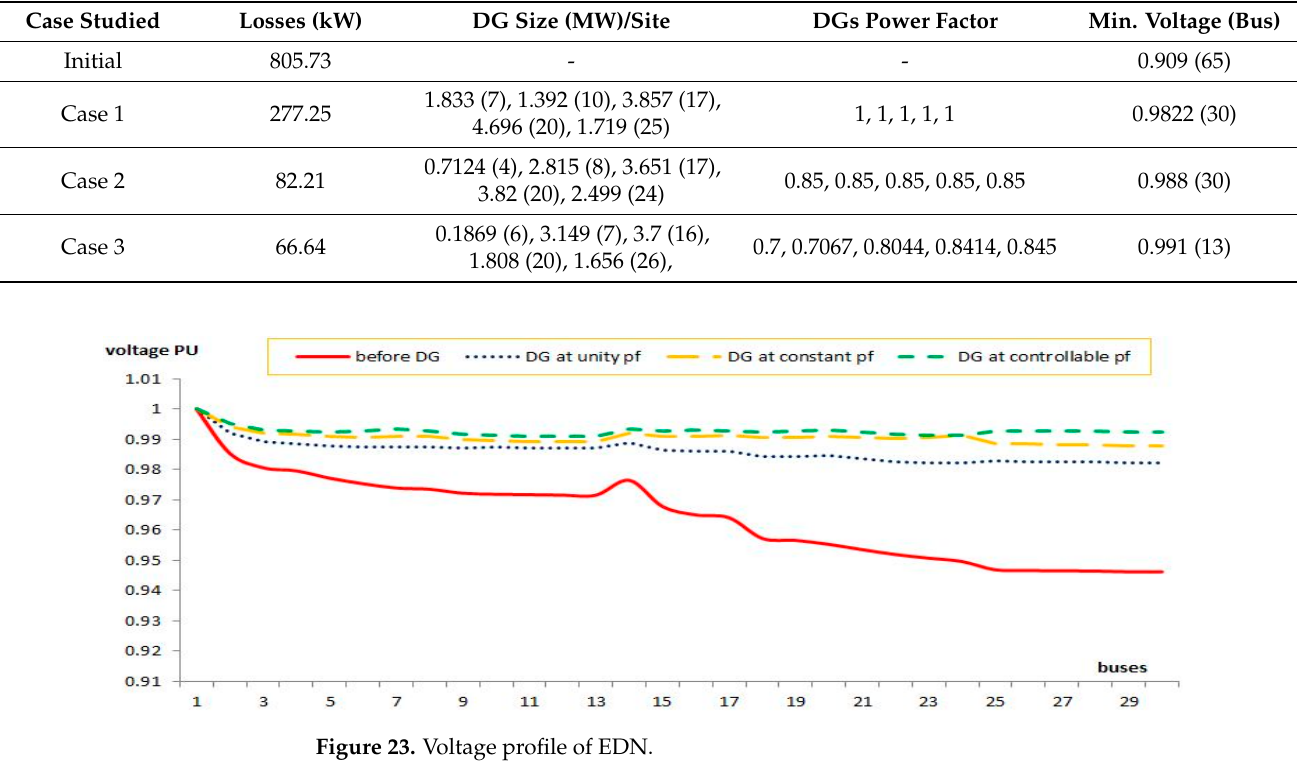
Figure 23. Voltage profile of EDN.